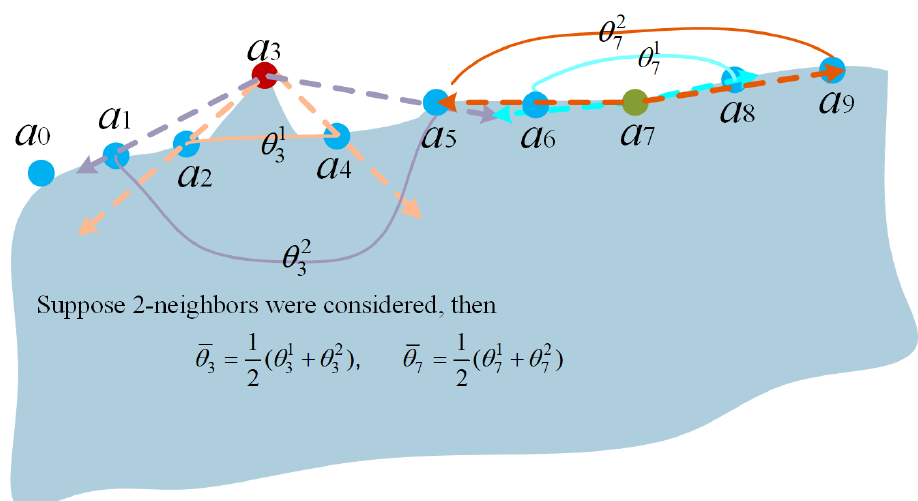
Figure 5. An example for calculating average fluctuation angle of sampling points of the segmented vertebra. ( a 0 , a 1 , . . . , a 9 ) are sampled points; θ j denotes the angle between a i and its j -th neighbor on the left and right; θ i denotes the average fluctuation angle of a i